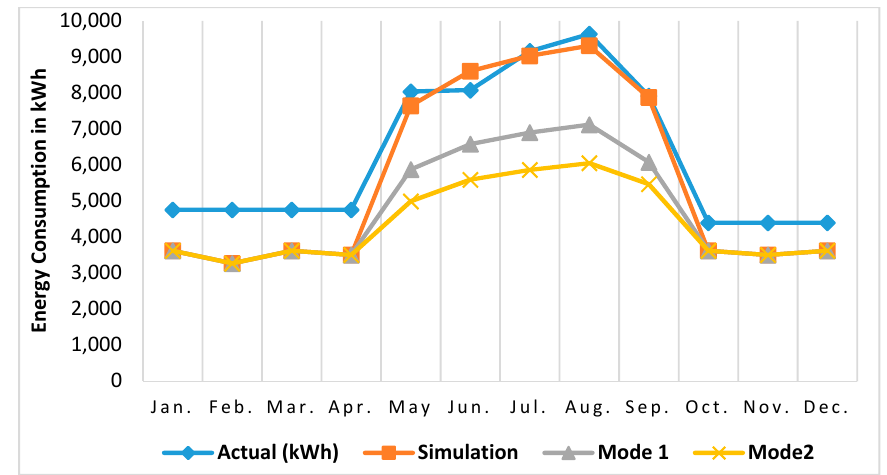
Figure 12. Actual readings and simulation results of energy consumption with thermostat setting to 20 °C under different AC operation modes for the villa.